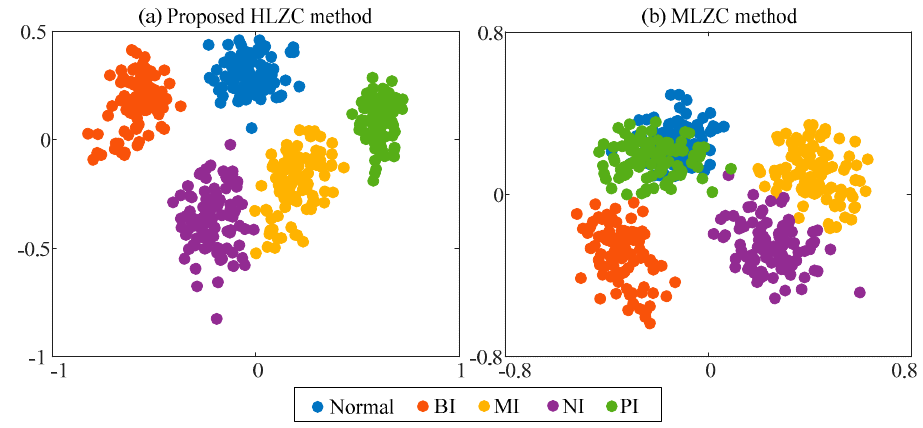
Figure 20. Projections of two-dimensional visualization of the obtained features in Experiment 2: ( a ) our proposed HLZC method, ( b ) traditional MLZC method.